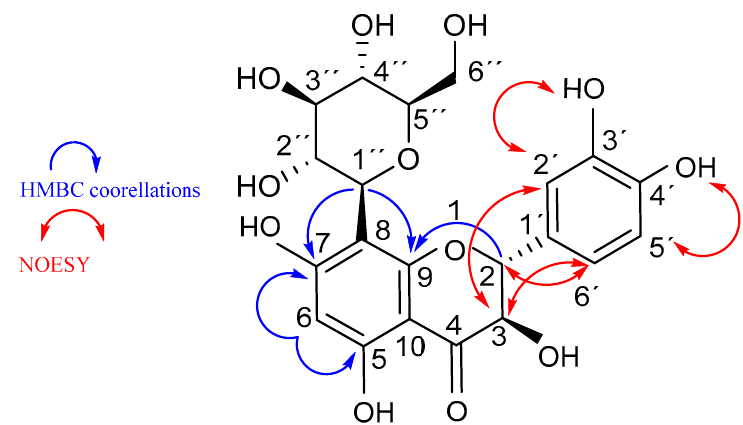
Figure 3. Fideloside ( 3 ) chemical structure with selected key NMR correlations.